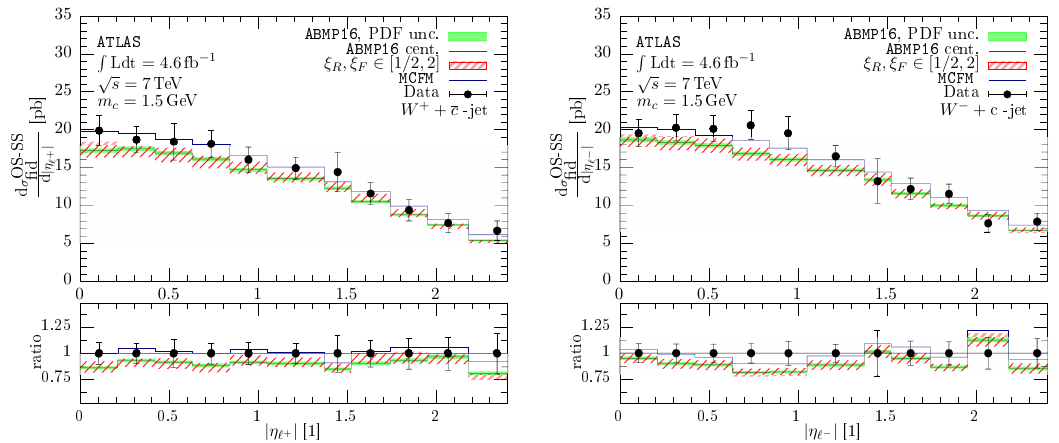
Figure 12 . Same as in figure 9 but for the ATLAS W + j c analysis cuts of ref. [21]. Also reported are the fixed-order NLO